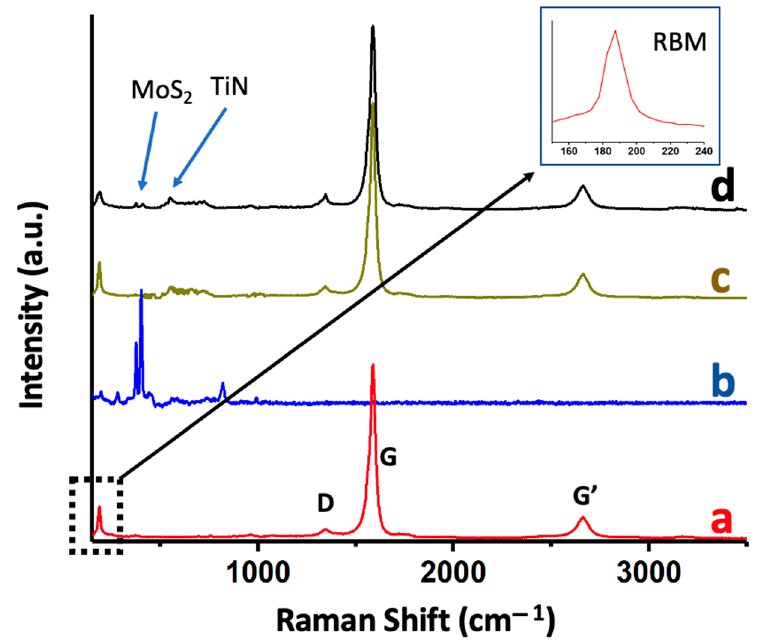
Figure 6. Raman spectra of as-synthesized SWCNTs (a); MoS 2 nanosheets (b); AuNPs-SWCNTs on TiN-SiO 2 -Si substrates (c); and MoS 2 -AuNPs-SWCNTs on TiN-SiO 2 -Si substrates (d).